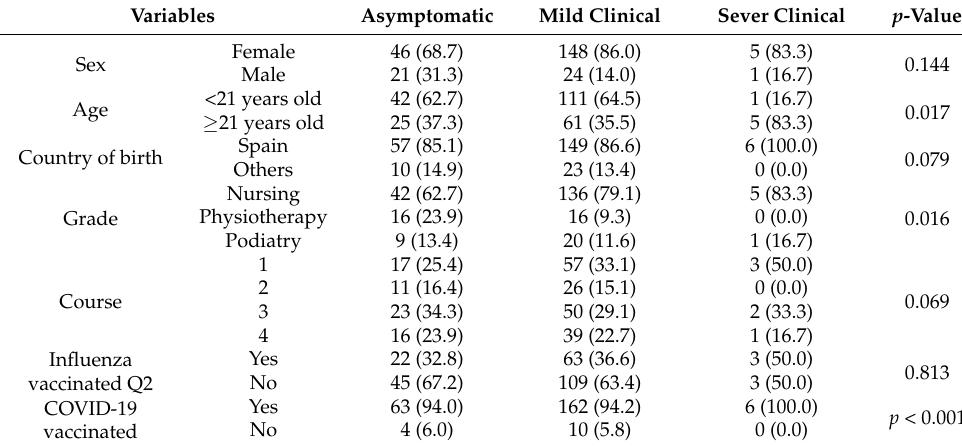
Table 6. Severity of COVID-19 as a function of different factors.